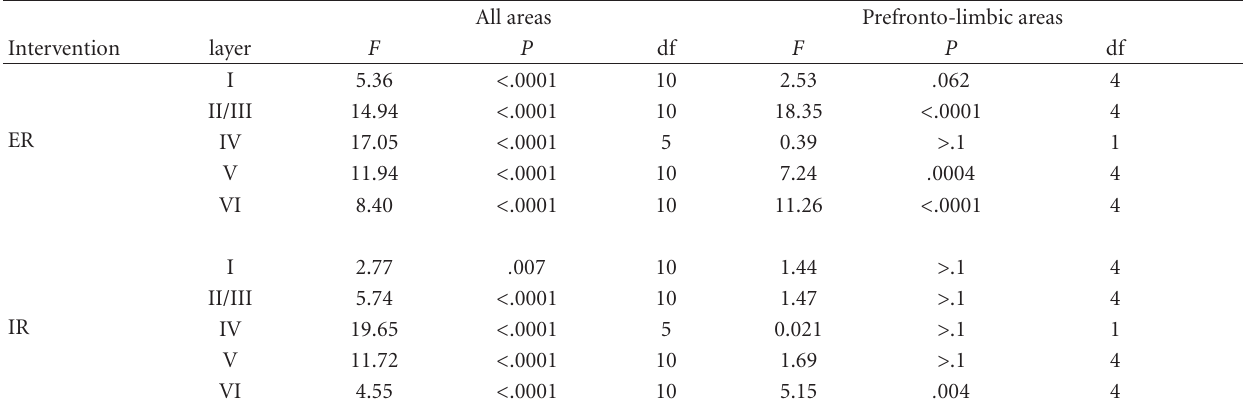
Table 1: Statistical results from one-way analysis of variance (ANOVA) with main factor “area” in animals under enriched (ER) and impoverished rearing (IR) conditions, conducted for all evaluated areas (left) and prefronto-limbic areas separately (right). All areas Prefronto-limbic areas